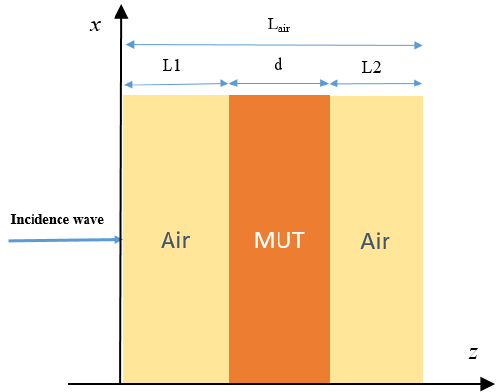
Figure 2. Multilayer structure of simulated measurement.